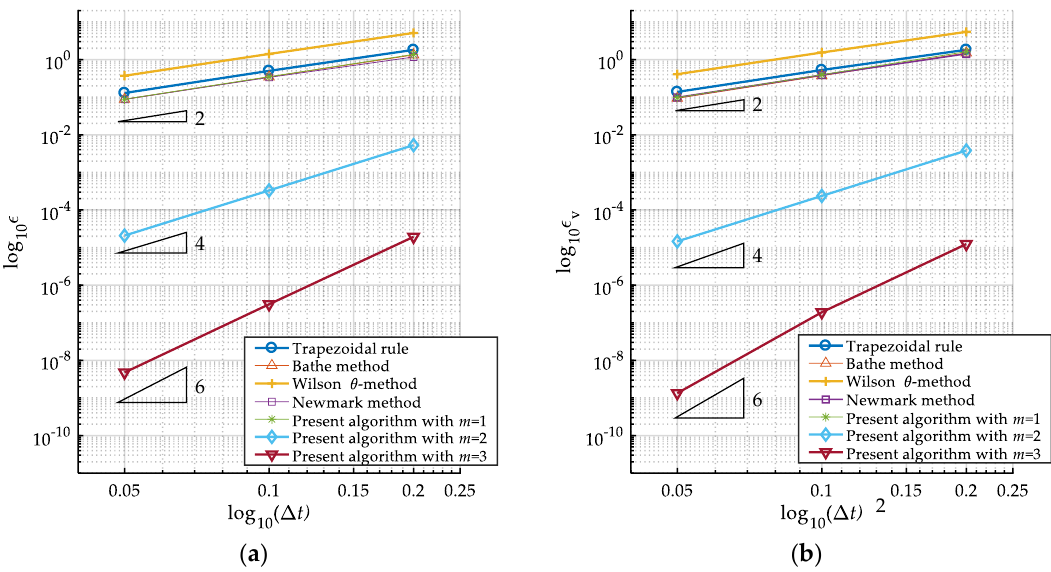
Figure 11. Convergence curves of displacements and velocities of the seven integration schemes: ( a ) Displacement/rotational angle. ( b ) Velocity.